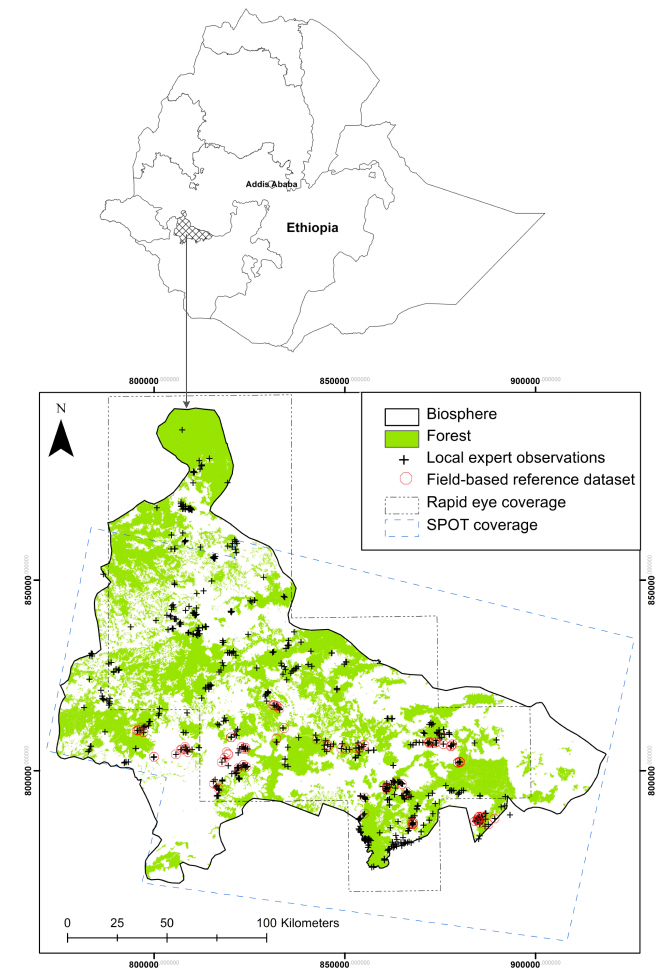
Figure 1. Study area in the UNESCO Kafa Biosphere Reserve, Southwestern Ethiopia; local expert observations (black crosses) were compared with a field-based reference dataset (red circles) and high resolution remote sensing data from the SPOT (footprint shown as a blue dotted line) and RapidEye (footprint shown as a black dotted line)